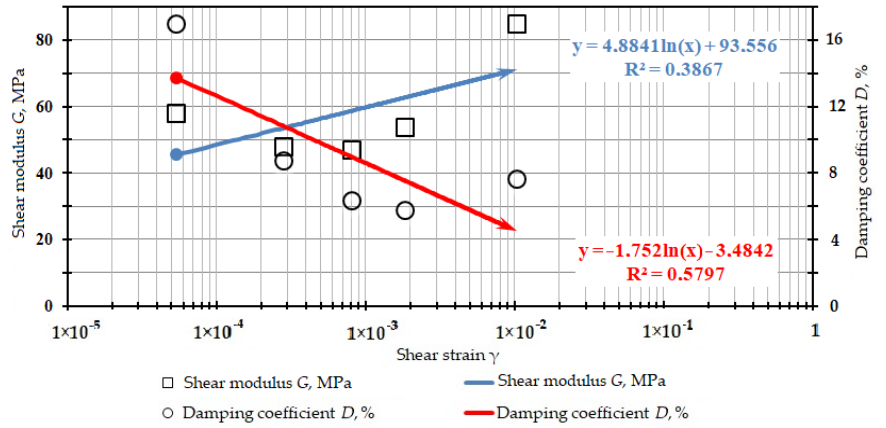
coefficient D (%) on the amplitude of shear strains γ (unit fractions) for cement sta bilized soils. Test